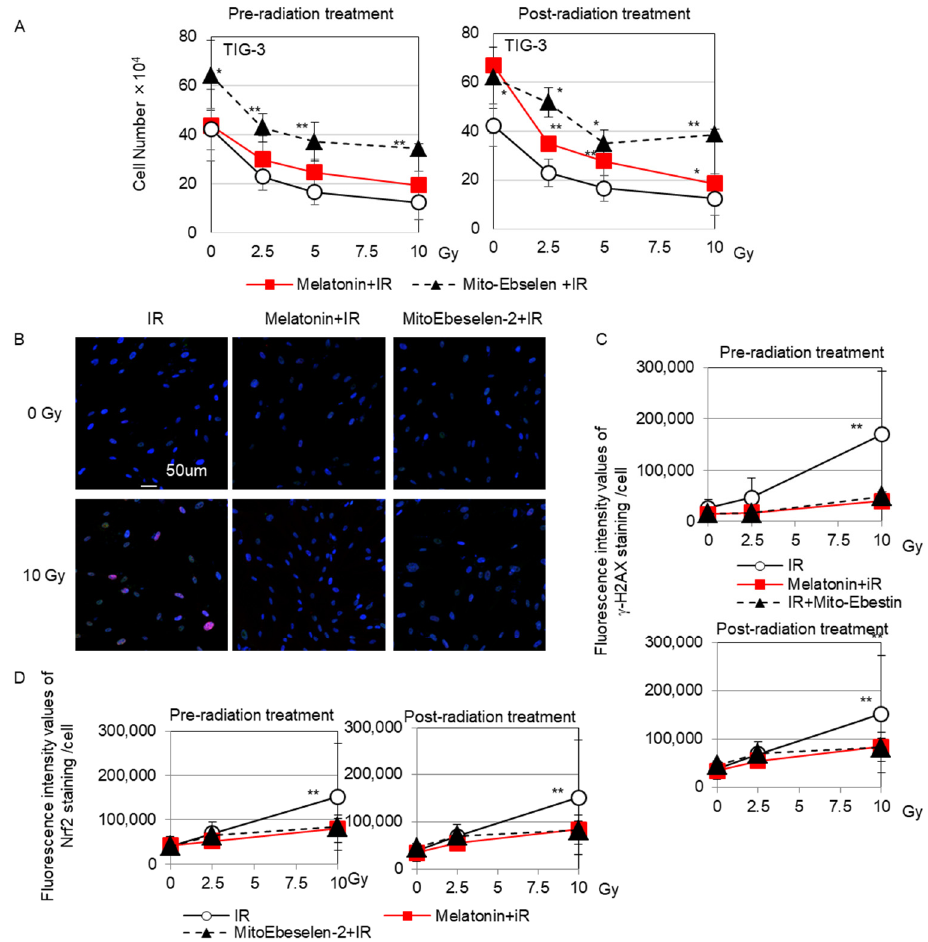
Figure 3. Cell growth, γ -H2AX foci formation, and nuclear accumulation of Nrf2 staining ( A ) The number of cells at 3 days after irradiation in indicated samples. Asterisk displays a significant difference in IR+ melatonin group and IR+ MitoEbselen-2 group compared with that of IR groups at same Gy level. ( B ) γ -H2AX foci (red) and nuclear accumulation of Nrf2 (green) were shown in irradiated TIG-3 cells. Scale bar = 50 µ m. Fluorescence intensity of γ -H2AX ( C ) and Nrf2 ( D ) is shown in the graph. Asterisk displays a significant change in fluorescence intensity values of the staining compared with that of non-irradiated control cells.